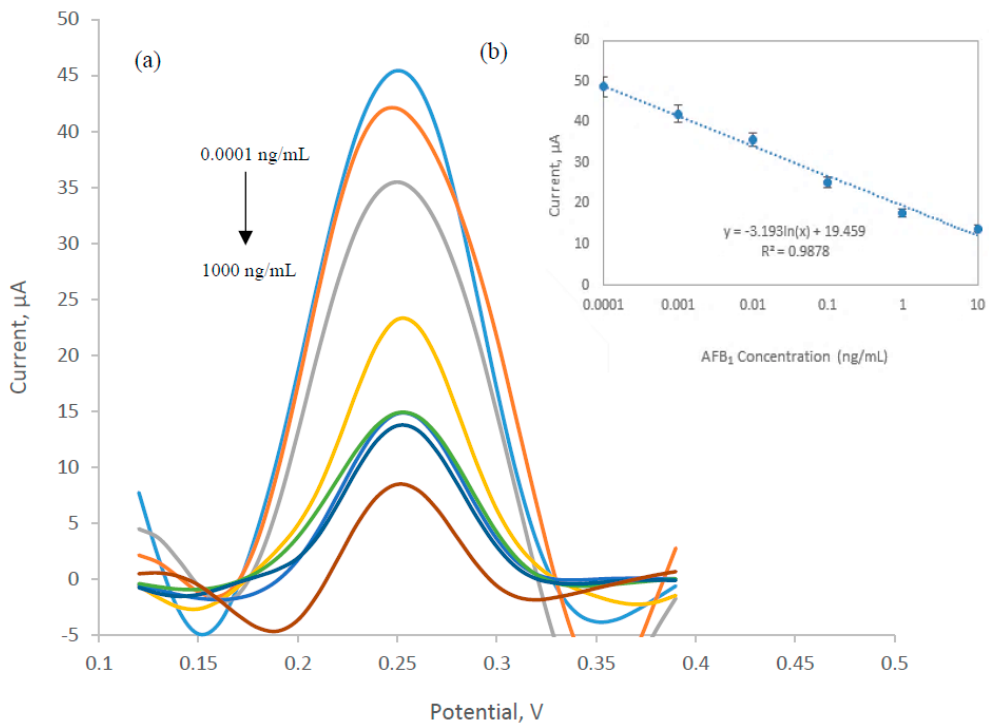
Figure 3. ( a ) Differential pulse voltammetry (DPV) analysis within the potential range of 0.1 to 0.4 V using TMB and 0.06% H 2 O 2 as substrate. Detection of AFB 1 was based on the reduction of TMB (Ox) by HRP enzyme. The current peaks were found at 0.25 ± 0.01 V. ( b ) Linear regression of standard curve for AFB1 within the range of 0.0001 to 10